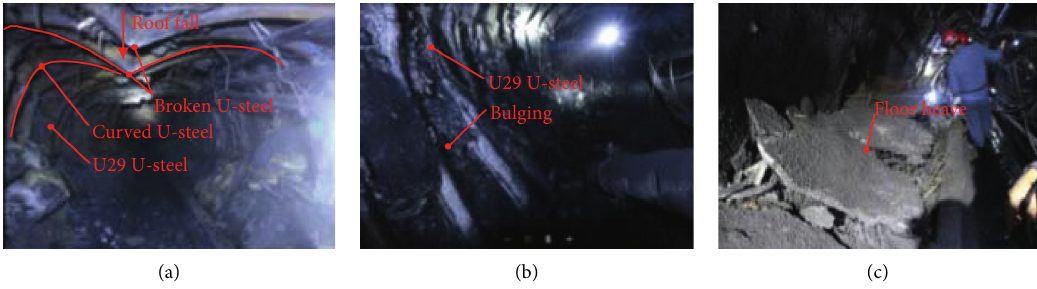
Figure 1: The damage of the crossheading supporting structure.